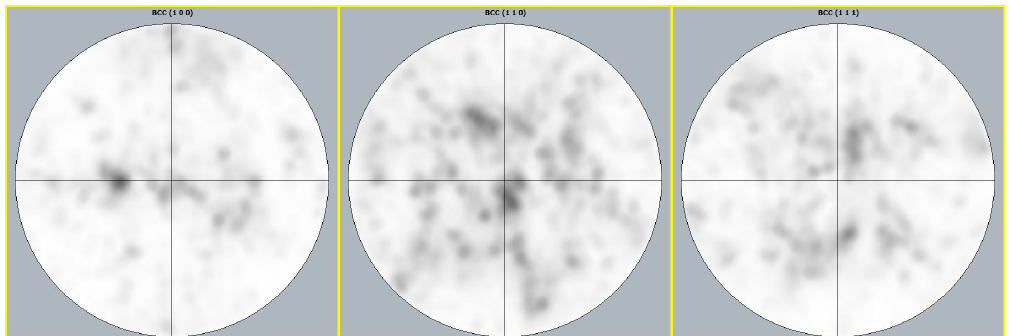
Figure 7. Pole figures of the as-built